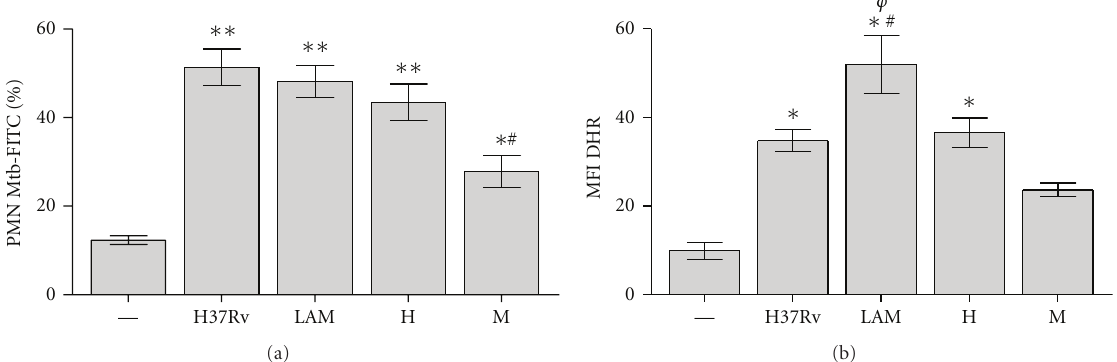
Figure 6: Phagocytosis of Mtb strains by PMN (a) As direct measure of phagocytosis, PMN were incubated with FITC-labeled Mtb (ratio 10:1). Then all Mtb -FITC bound/not ingested by PMN were quenched with Trypan Blue. Results represents bound/ingested plus ingested and are expressed as media ± SEM of MFI ( n = 10). Statistical di ff erences: Control (—) versus H37Rv, LAM and H: ∗∗ P < 0 . 001 control versus M ∗ P < 0 . 05; M versus other strains # P < 0 . 001. (b) Phagocytosis was indirectly measured by ROS production induced with DHR labeled Mtb (DHR Mtb ). PMN were incubated with DHR Mtb (50:1 ratio) for 90 min. at 37 ◦ C and 123rhodhamine emission was evaluated immediatly in a flow cytometer. Results are expressed as media ± SEM of MFI ( n = 10). Statistical di ff erences: control (–) versus H37Rv, LAM and H: ∗ P < 0 . 001; LAM versus H37Rv and H # P < 0 . 05; LAM versus M ϕ P < 0 . 001. In all cases PMN were washed, and 10,000 events were collected in a flow cytometer as described in Section